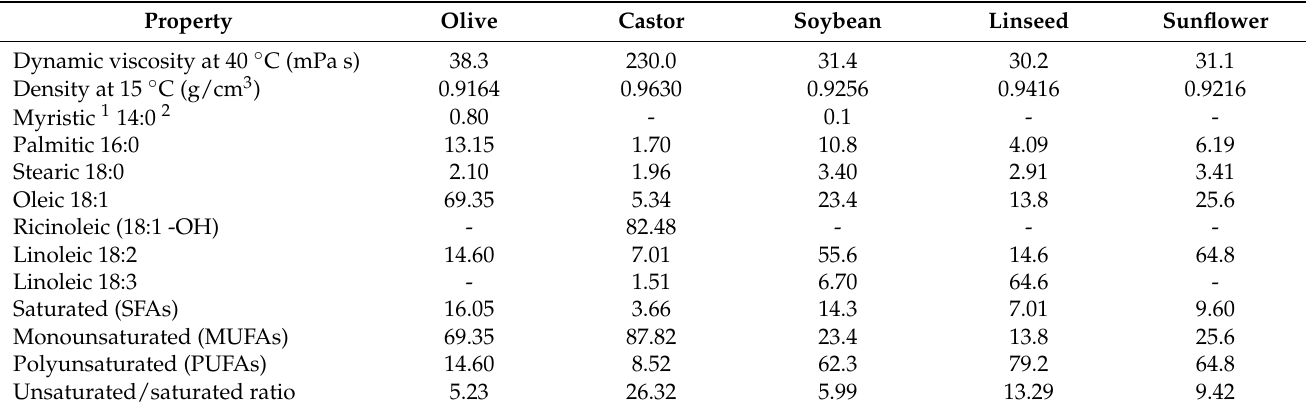
Table 4. Physicochemical properties and fatty acid composition of vegetable